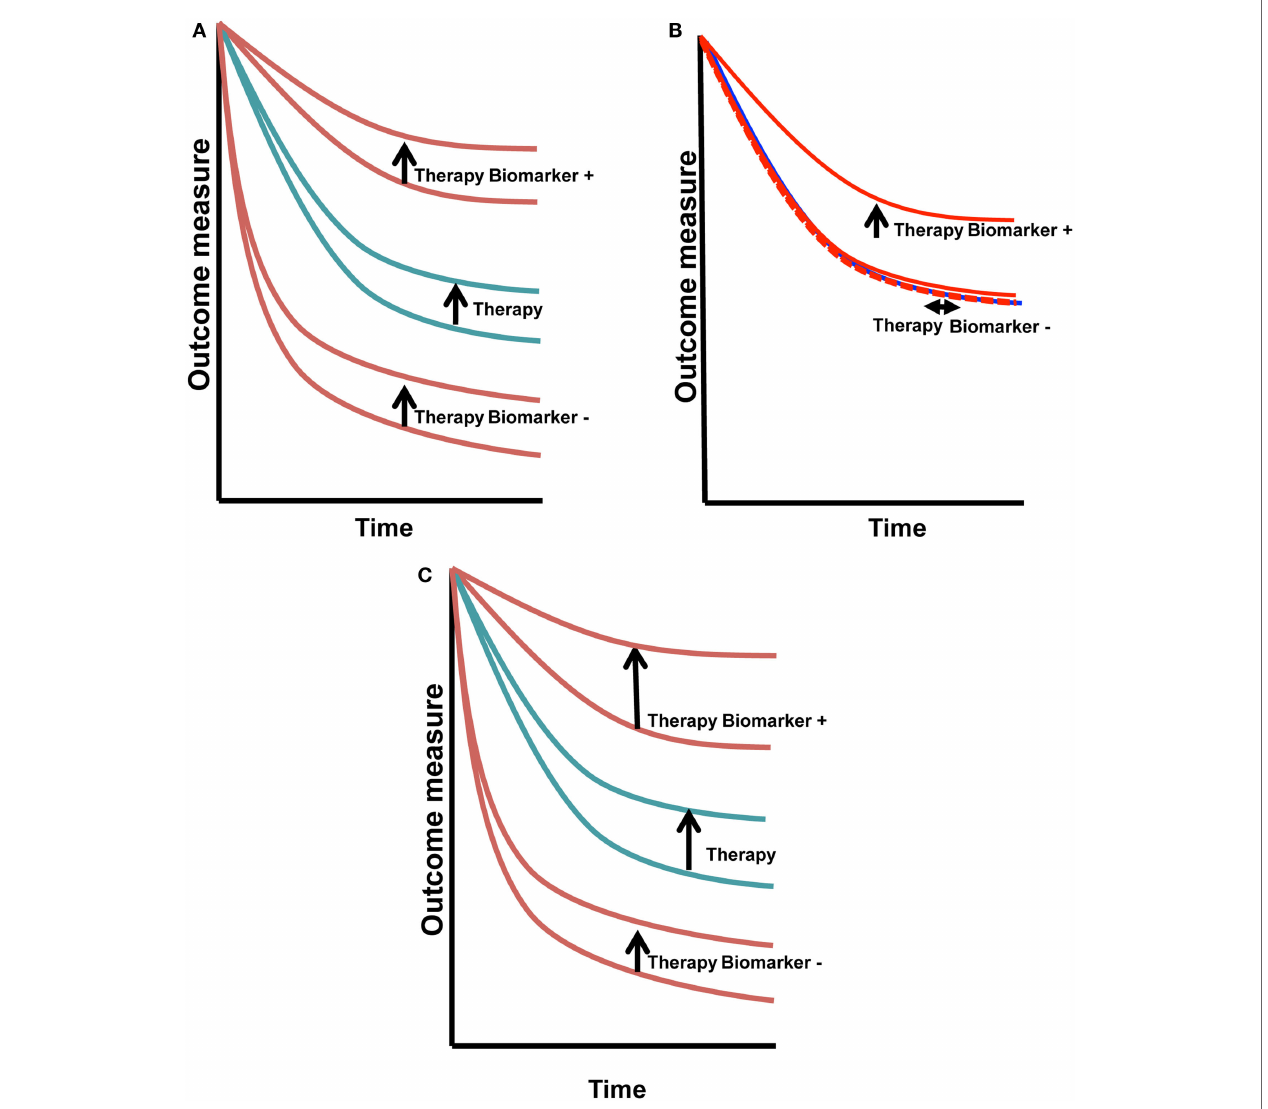
FiGURe 1 | Predictive vs. prognostic biomarkers . Prognostic biomarkers (A) have similar change in outcome with therapy that is independent of the biomarker status. Predictive biomarkers (B) have a treatment/outcome interaction, seen in this example as improvement with treatment in biomarker + cases (vertical arrow), with absence of change in the biomarker − cases (horizontal arrow). Biomarkers that may be both prognostic and predictive (C) will shift the biomarker + curve the same or greater if both the prognostic and predictive effects are positive. If one is positive and the other is negative, the outcome may cancel. This is a more complex situation to